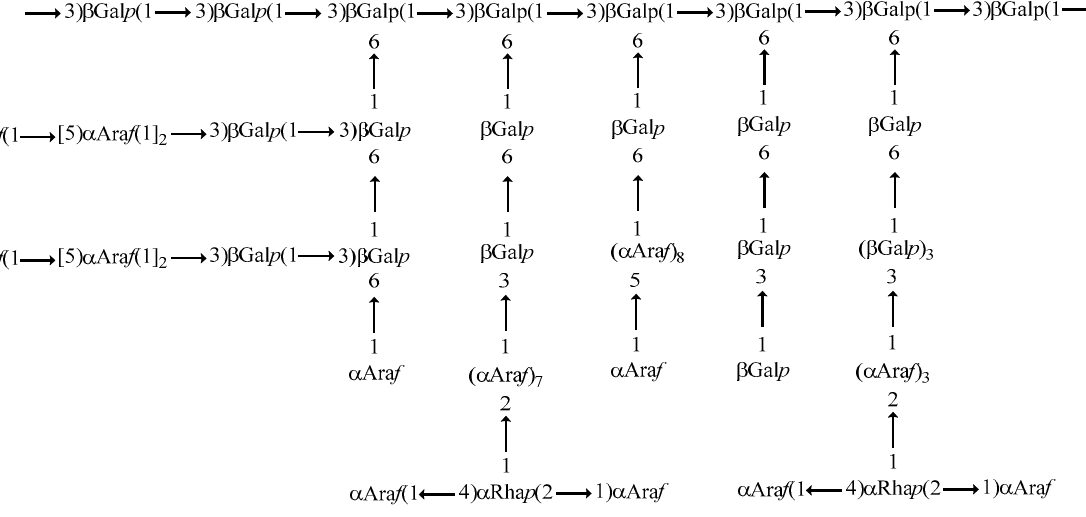
Figure 20. Hypothetical structure of the repeat unit of the glycan of LRGP3.